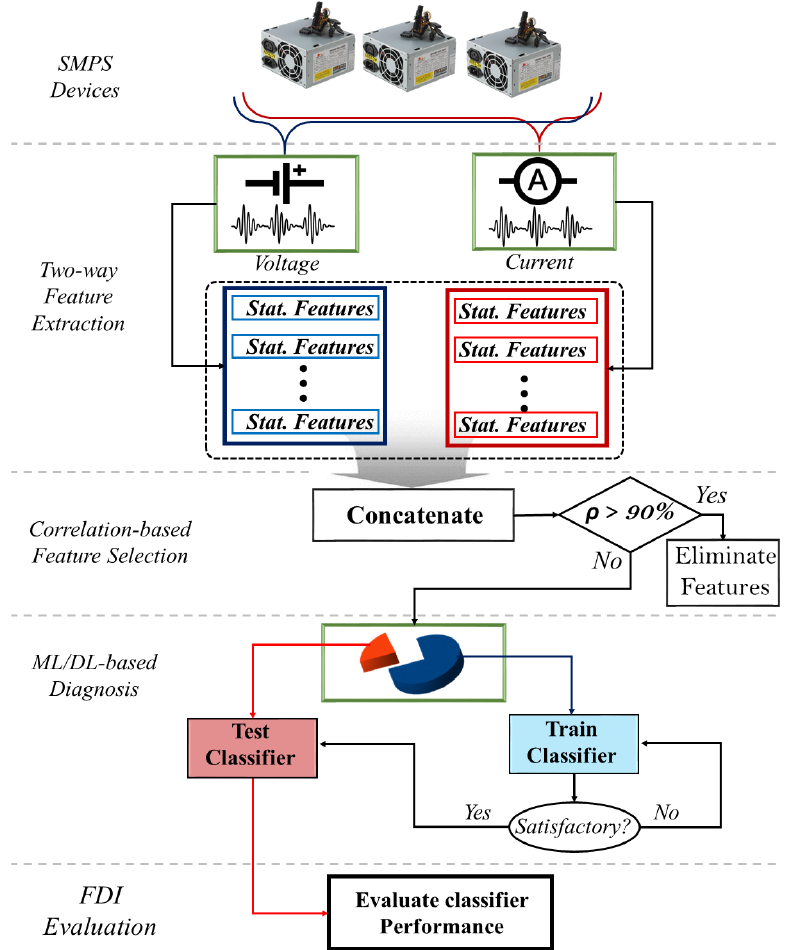
Figure 3. Proposed Framework for SMPS Switching Devices